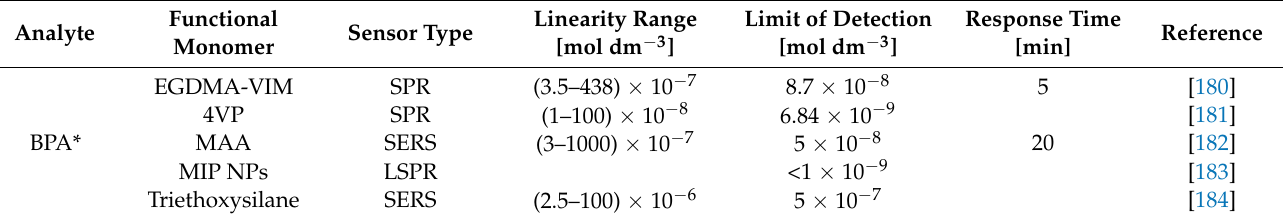
Table 6. MIP plasmonic sensors for BPA detection and their